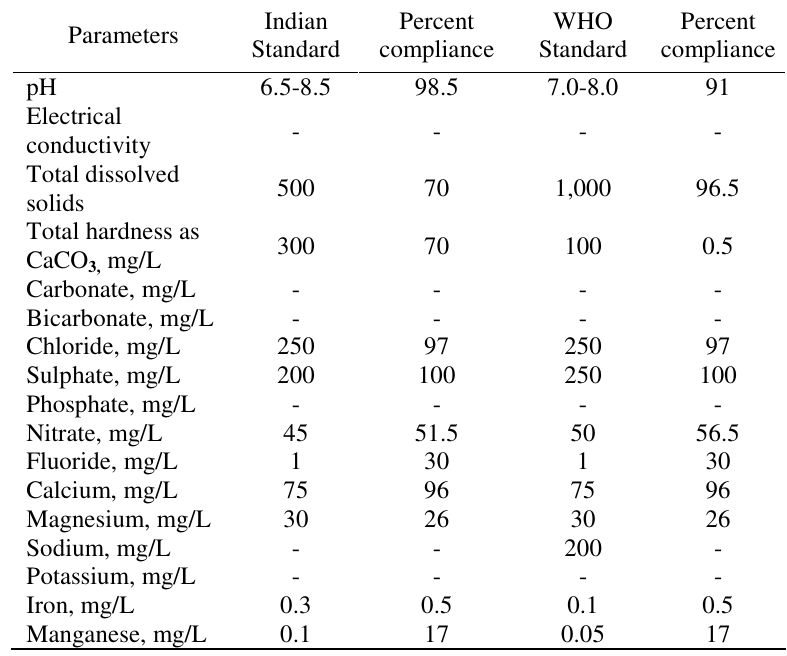
Table 1. Comparison of groundwater quality with drinking water standards, Indian and